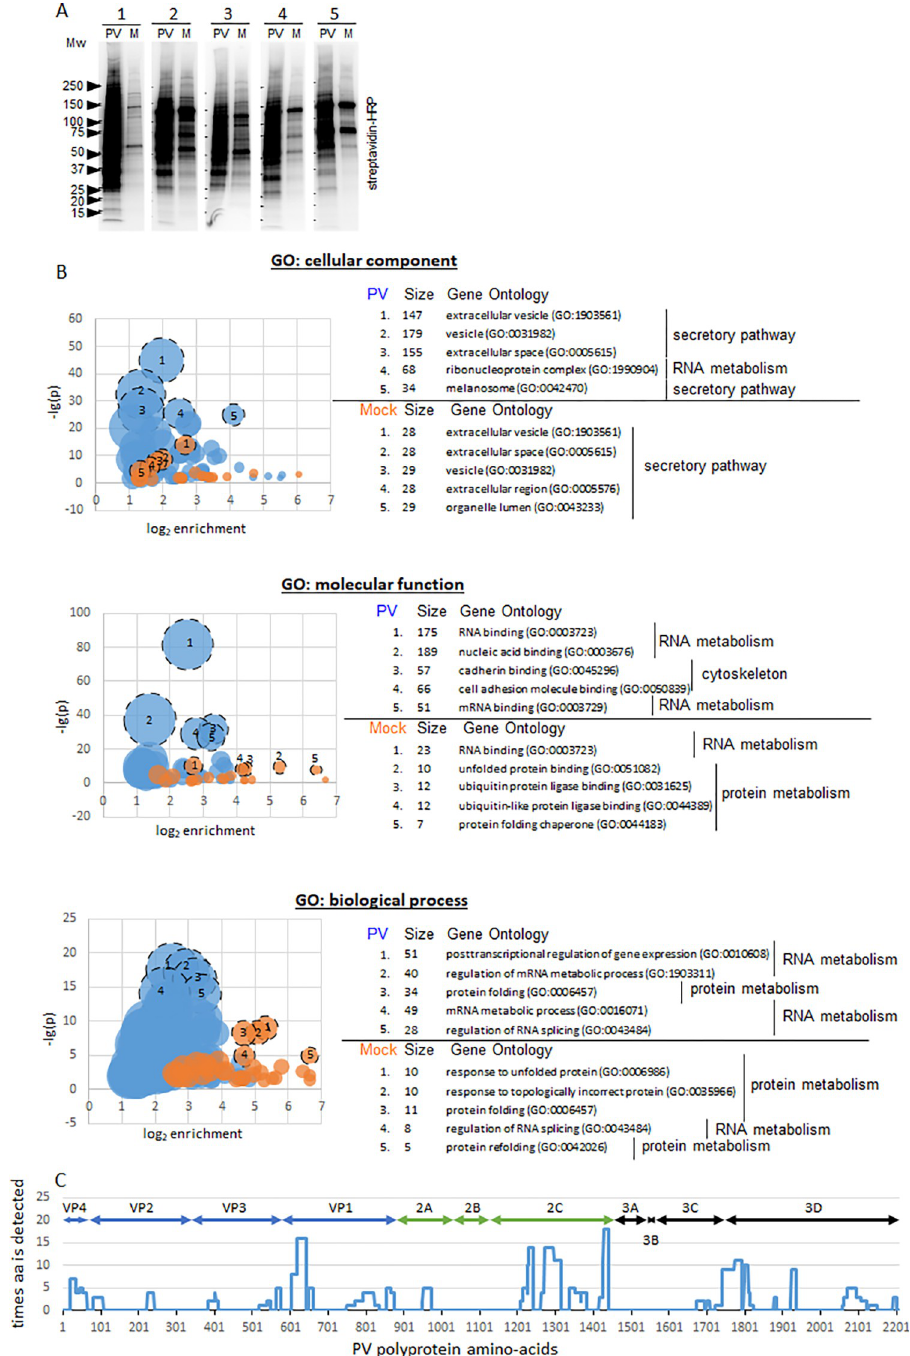
Fig 4. Characterization of the proteome biotinylated by FLAG-APEX2-GARG1060. A. In five independent experiments, HeLa cells stably expressing APEX2-GARG-1060 were infected (PV), or mock-infected (M) with 10 PFU/ cell of poliovirus, and biotinylation was performed at 6 h p.i. Biotinylated proteins were purified on streptavidin beads and analyzed in a Western blot with HRP-streptavidin. Biotinylated proteins from these five experiments were pooled for proteomics analysis. Full proteomics data are available in S1 Data. B. Gene ontology (GO) enrichment analysis of the proteomics data using PANTHER classification system [69]. Buble graphs show the number of proteins associated with a particular GO term (bubble size), the log 2 of enrichment over the expected non-specific associations of genes in the dataset with a particular GO term (x-axis), and the statistical significance of the observed enrichment (negative log 10 of p-value, y-axis). Five of the most statistically significantly enriched GO terms for proteins from infected and